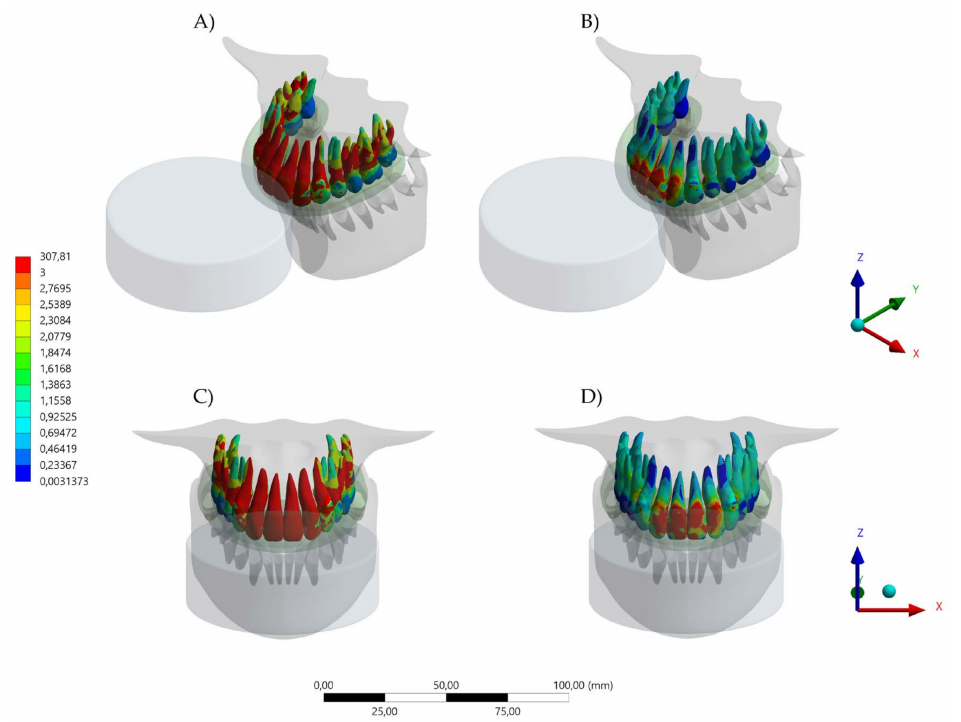
Figure 6. Von Mises Stress result in upper teeth. ( A ) Isometric view of the upper teeth stresss with the conventional design and ( B ) isometric view of the upper teeth stresss with the hybrid (HMG) design. ( C ) Buccal view of the upper teeth stresss with the conventional design and ( D ) buccal view of the upper teeth stresss with the hybrid (HMG) design.